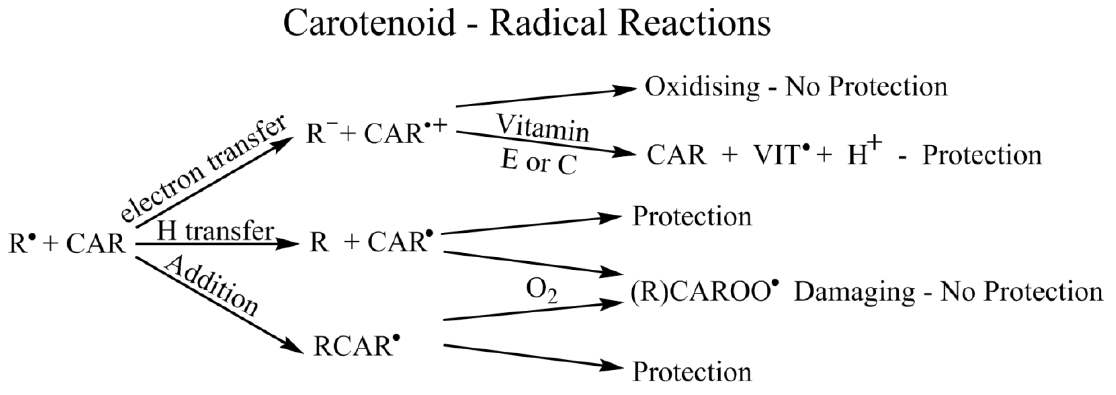
Figure 7. Summary scheme of carotenoid reactions with free radicals .